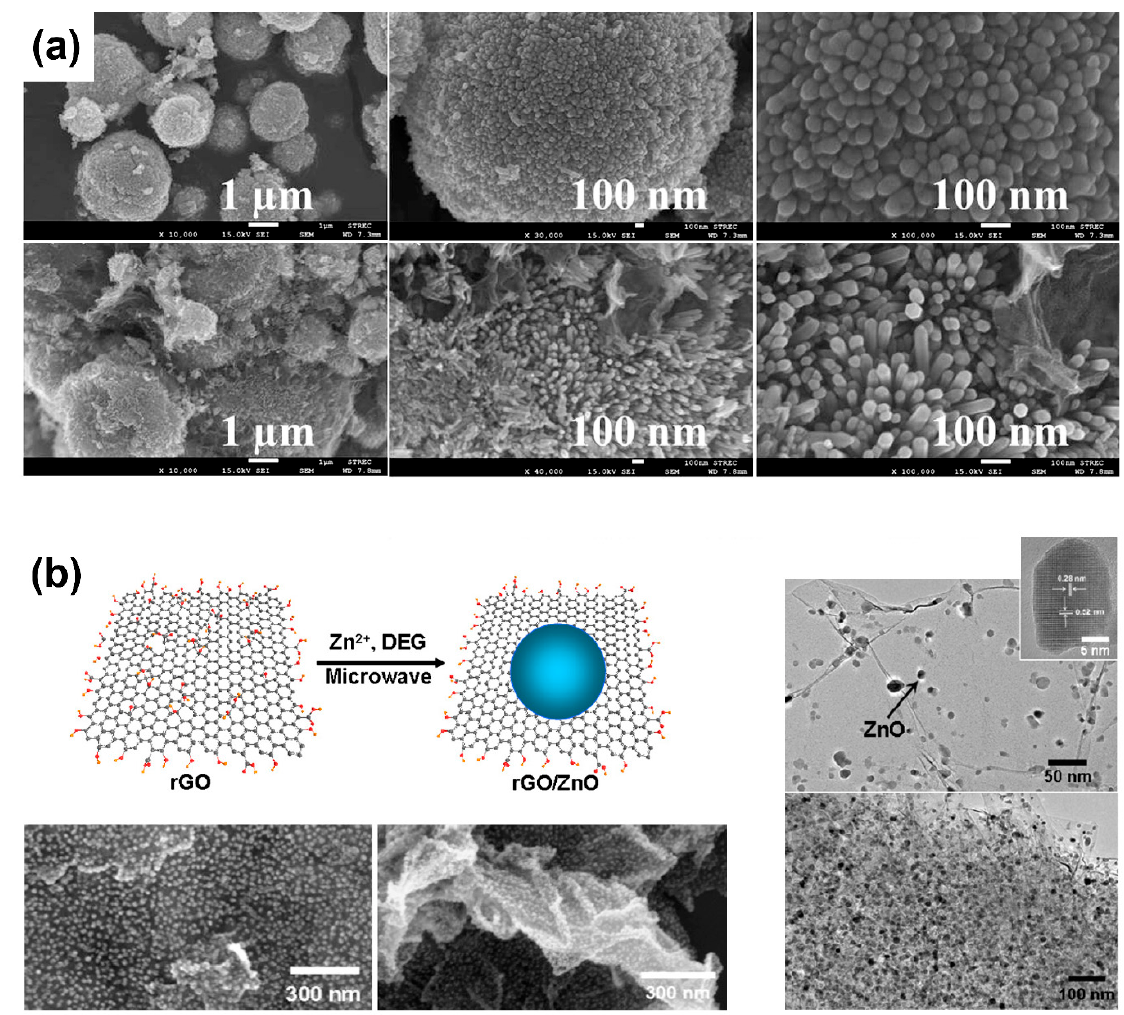
Figure 8. ( a ) Scanning electron microscopy images of ZnO microspheres (top), and ZnO microspheres-rGO composites (bottom). Adapted with permission from ref. [93]. Copyright © 2017, Elsevier. ( b ) Schematic illustration of the synthesis of rGO/ZnO nanocomposites (left), scanning electron microscopy (left) and transmission electron microscopy (right) images of rGO/ZnO nanocomposites. Adapted with permission from ref. [114]. Copyright © 2012, Elsevier.